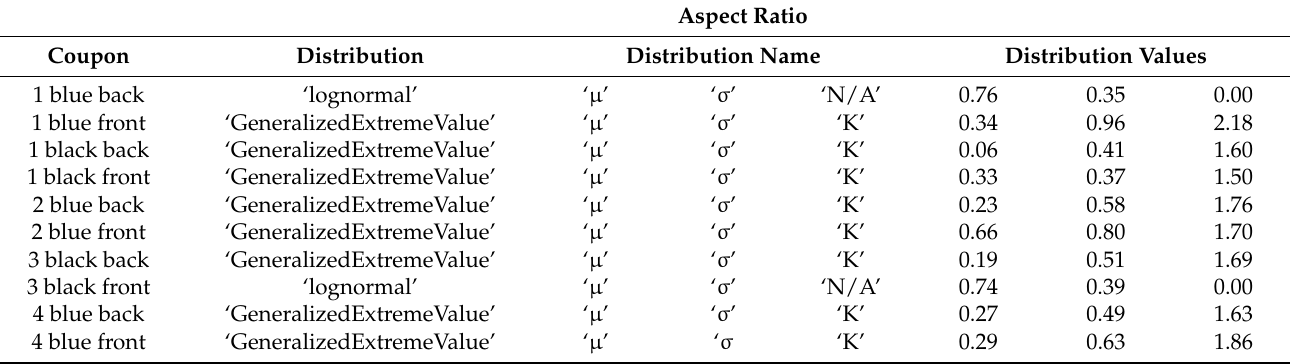
Table 6. AR statistical fit.